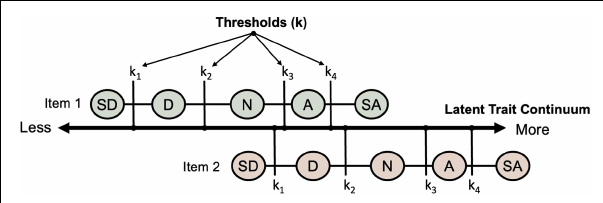
FIGURE 2 | Rating scale thresholds (where SD = strongly disagree; D = disagree; N = neutral; A = agree, and SA = strongly agree; each is assigned a numerical ordering of 1–5, respectively). The response category thresholds are represented along the latent continuum of the